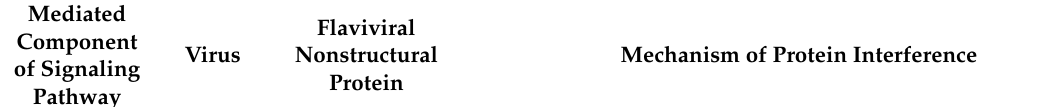
Table 1. Flaviviridae nonstructural proteins’ interference with TLR